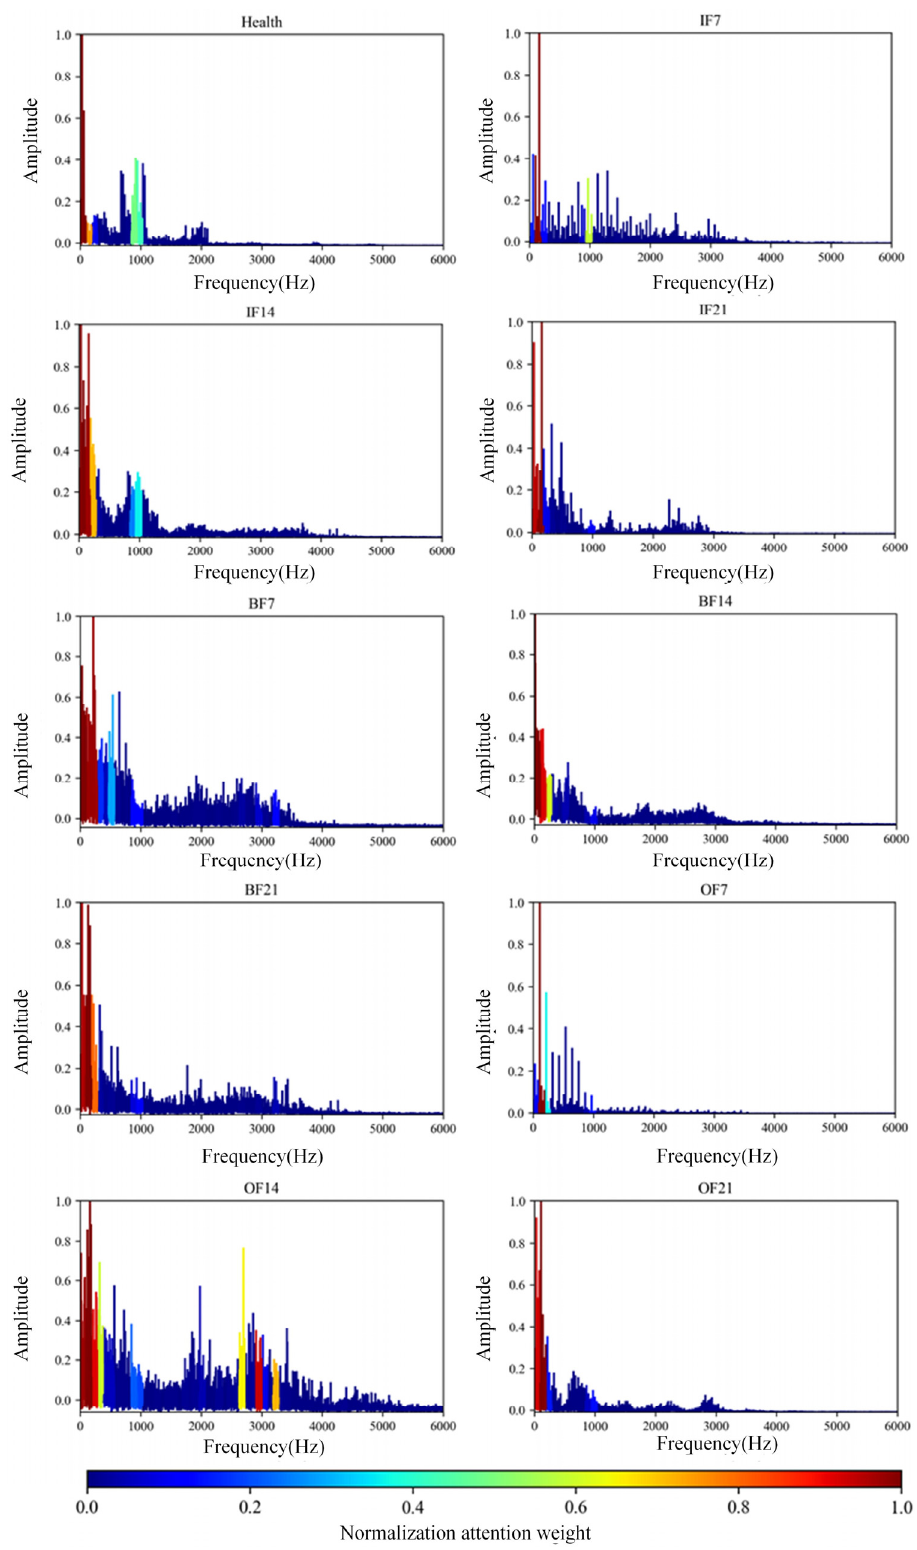
Figure 11. Visualization of attention weights for each working condition.